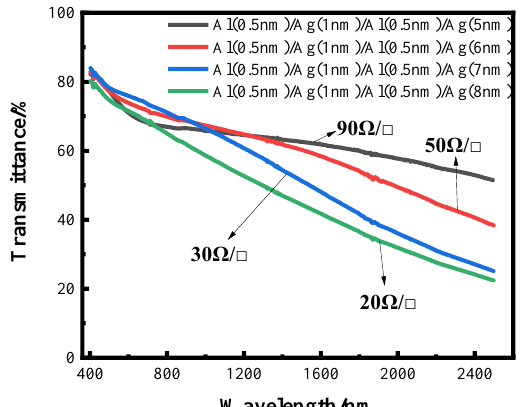
Figure 9. The transmittance curve of transmittance as a function of wavelength for alternating deposition of Al seed layer and Ag film.